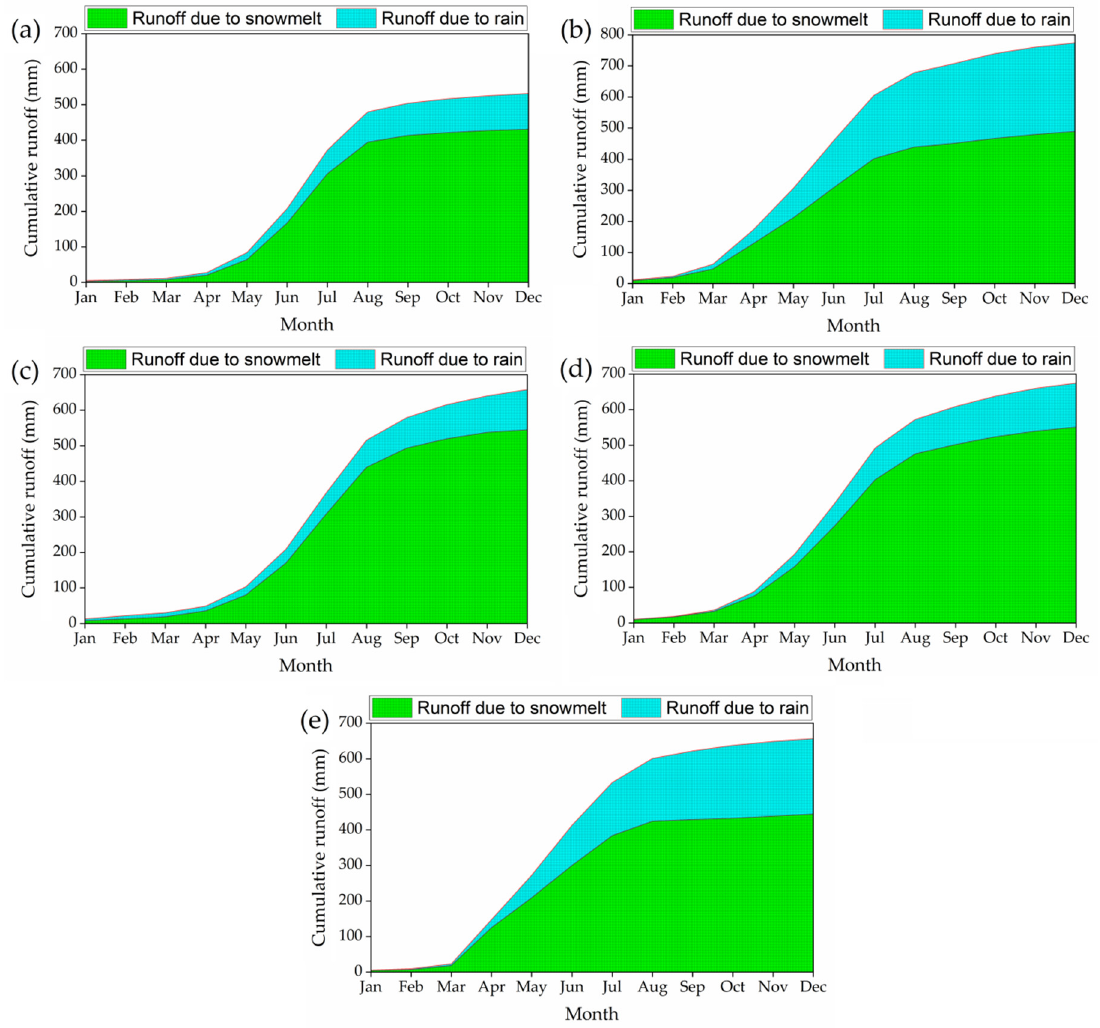
Figure 10. Cumulative curves of the runoff input components for the Upper Vakhsh River, using the SWAT model with ( a ) APHRODITE_V1101+CFSR, ( b ) APHRODITE_V1101+CRU TS3.1, ( c ) CFSR, ( d ) CRU TS3.1, and ( e ) observational datasets.